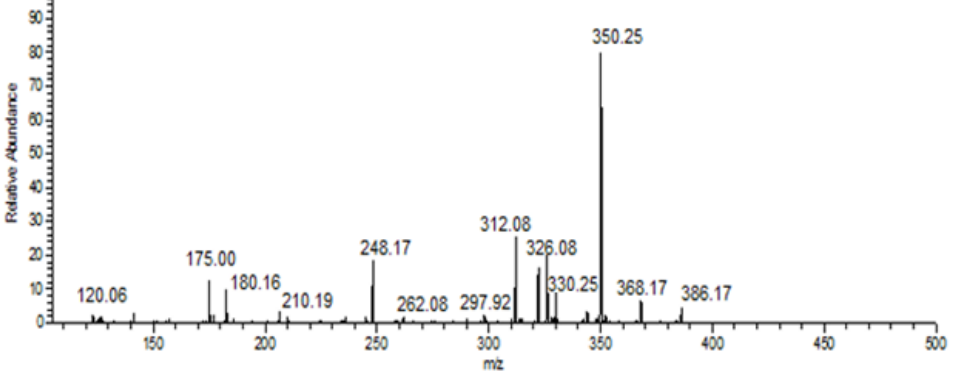
Figure 9. LC–MS analysis of treated sample of Reactive Yellow 160A. UV Irradiation. Time = 120 min, [TiO 2 ] = 450 mg/L pH = 3, [RY-160] = 30 mg/L.